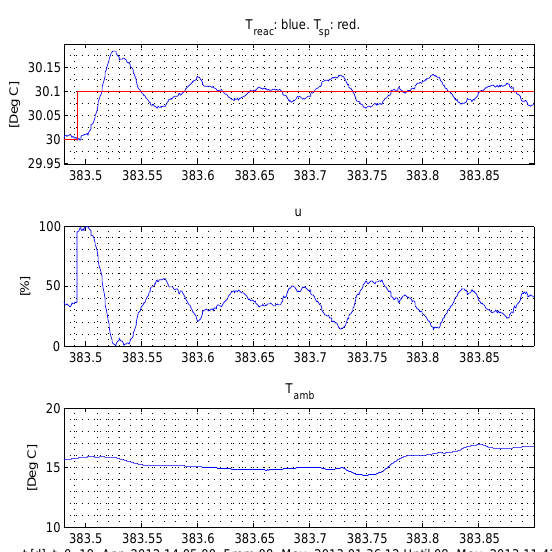
Figure 9: Real time-series for reactor with PI temper- ature controller tuned with relay-based ZN